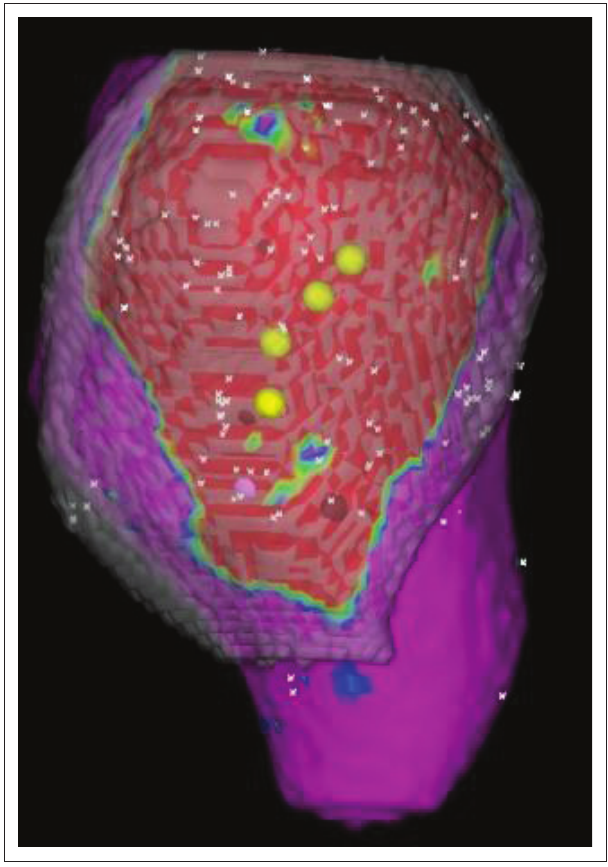
FIGURE 4: Registration of EAM and late gadolinium MRI. There is a slight mismatch on the left side of the image, where an area of normal voltage on EAM (purple) is superimposed on an area of scar on MRI (gray). This resulted from a gap in sampling on the